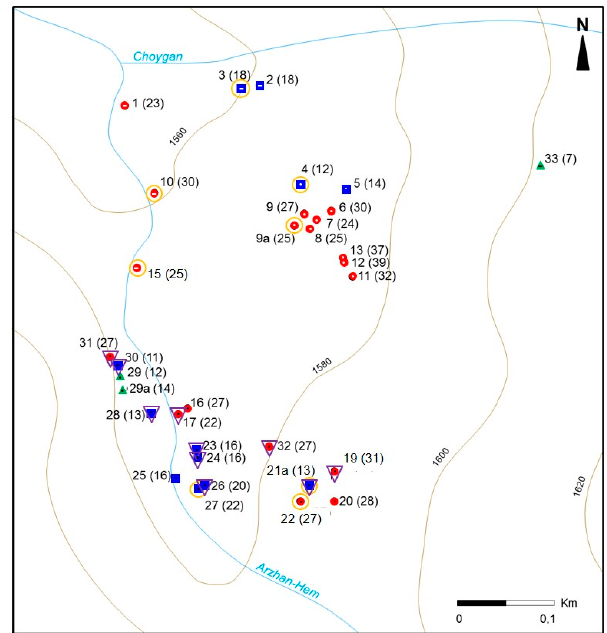
Figure 2. Location of sampling points in the Choygan field. Temperatures ( ◦ C) of spring water given in parentheses. Red closed circle—higher temperature thermal CO 2 -rich waters, blue close square—lower temperature thermal CO 2 -rich waters, green triangle—shallow groundwater; an open yellow circle shows CO 2 > 35 vol.%; an open purple diamond—SO 4 > 0.4 meq/L. Grouping of samples based on a geographical location on study area:white dots—group of samples 4, 5, 6, 7, 8, 9, 9a, 11, 12, 13; black dots—group of samples 16, 17, 19, 20, 21a, 22, 23, 24, 25, 26, 27, 28, 29, 29a, 30, 31, 32; white dash—group of samples 1, 2, 3, 10, 15; black dash—spring 33.